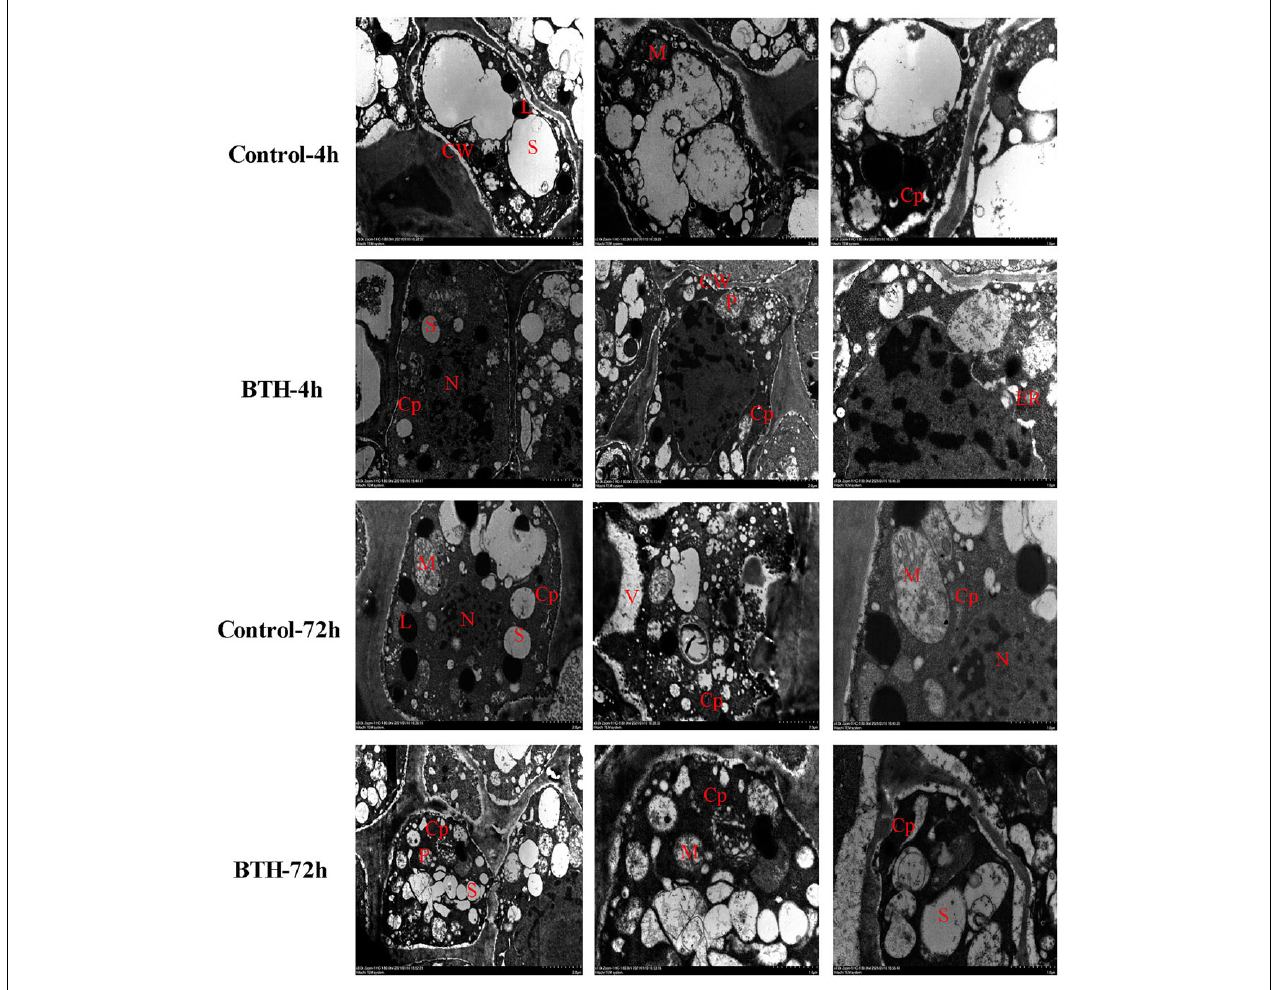
FIGURE 1 | The cellular Ca 2 + distribution in healing tissues of potato tubers. Black spots represent Ca 2 + pyroantinonate precipitate particles. S: starch; Cp: cytoplasm; CW: cell wall; N: nucleus; M: mitochondria; L: lipids; ER: endoplasmic reticulum; V: vacuole.